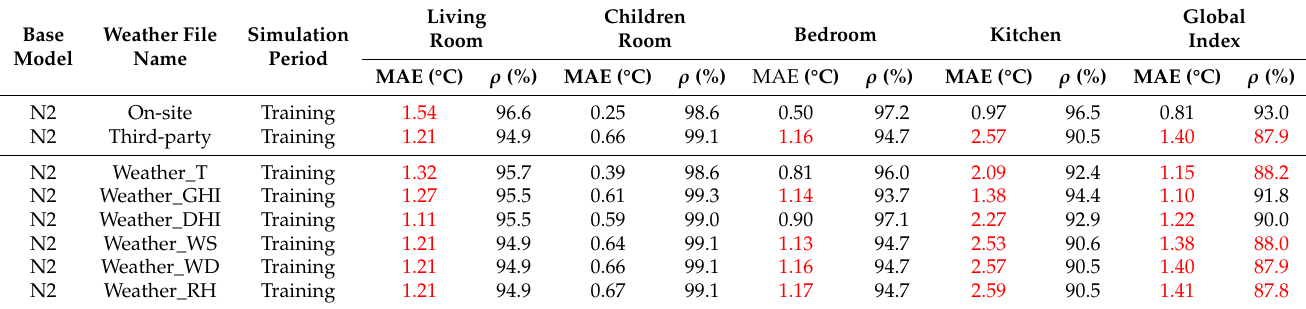
Table A1. MAE and ρ indices per thermal zone in the training period. House N2, base model.